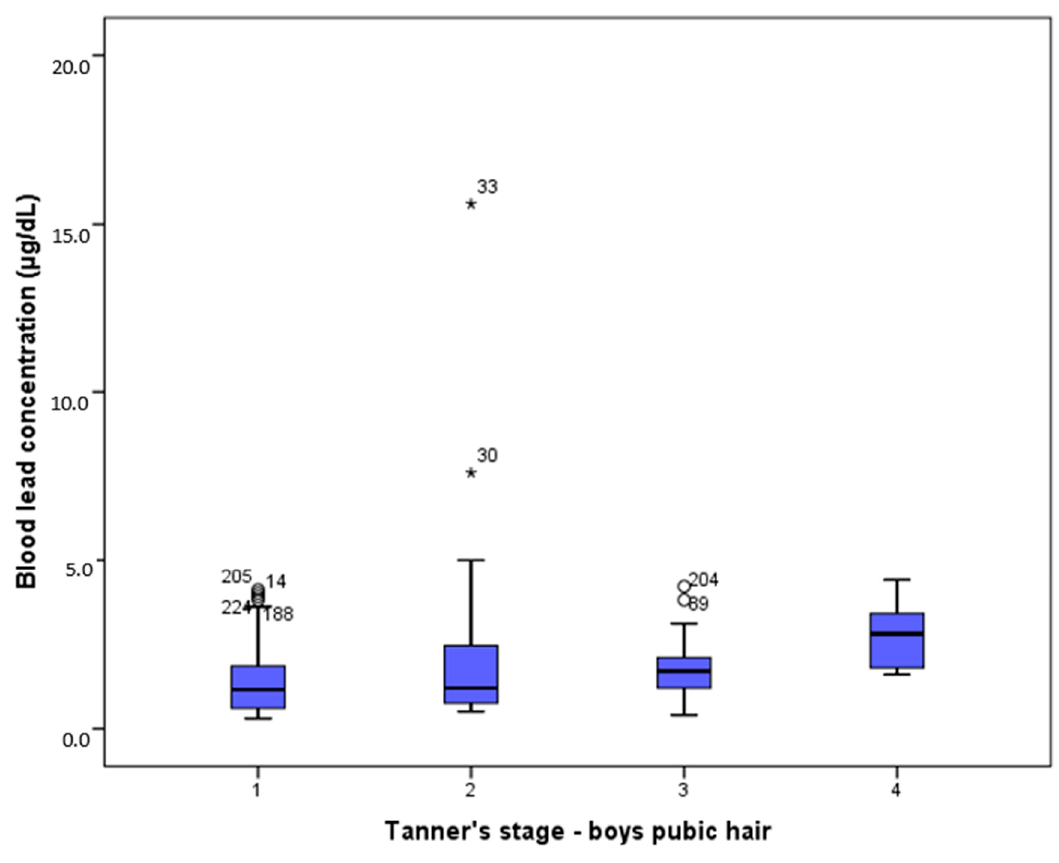
Figure 1. Box plot of PbB levels according to stages of pubic hair maturation in boys, according to Tanner. * denotes outliers.